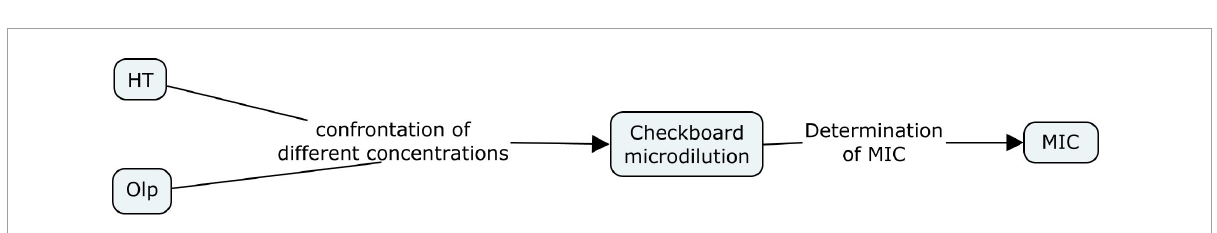
FIGURE2 Flow diagram of the in vitro study of different concentrations of hydroxytyrosol (HT) together with oleuropein (Olp) against Helicobacter pylori strains NCTC 11638 and HP661 (Behzadi and Gajdács,